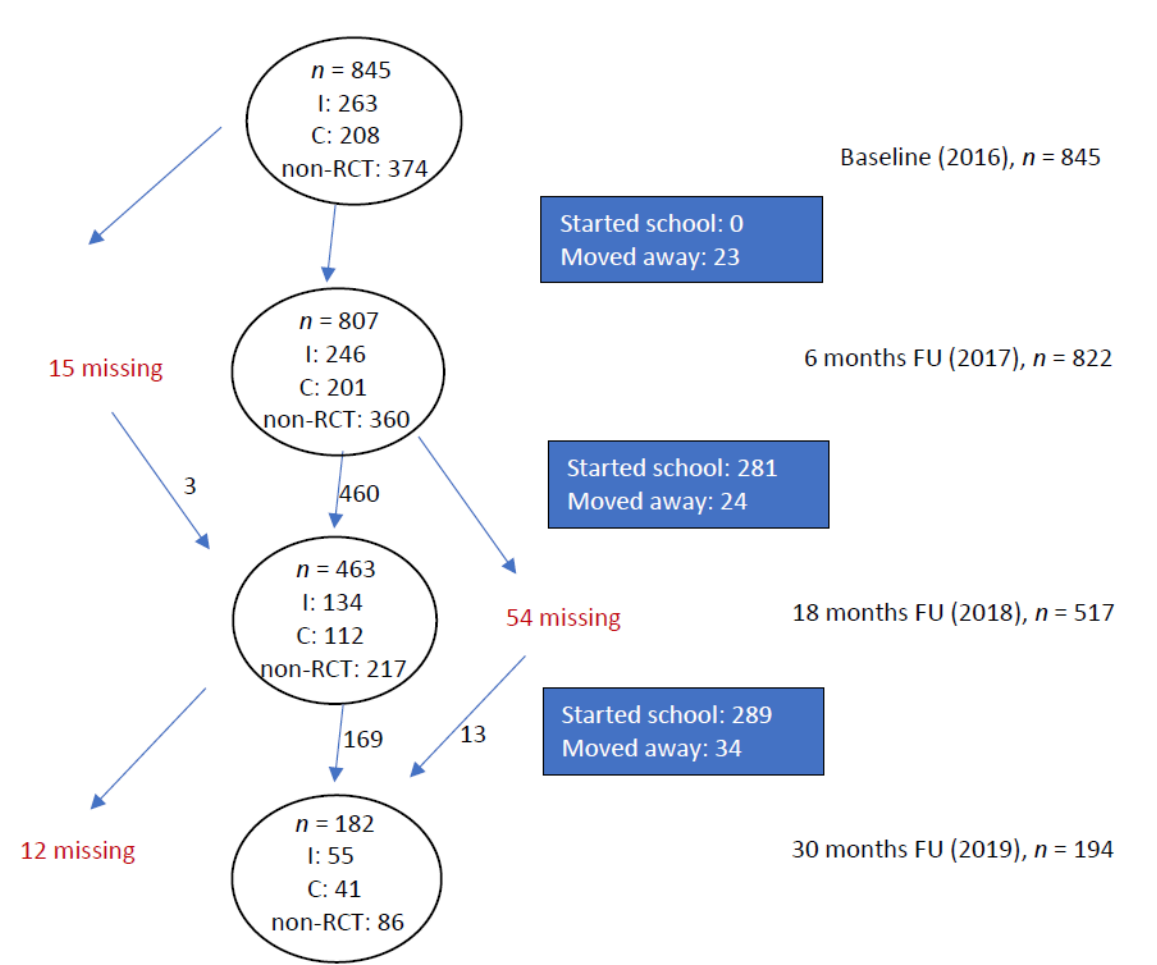
Figure 1. Movement ABC-2 measurements for the full cohort, including distributions in intervention groups. I: Intervention group; C: Control group; non-RCT: participating in the cohort but not the RCT; FU: Follow-up. Table 2. Baseline description of the cohort by participants and non-participants in the